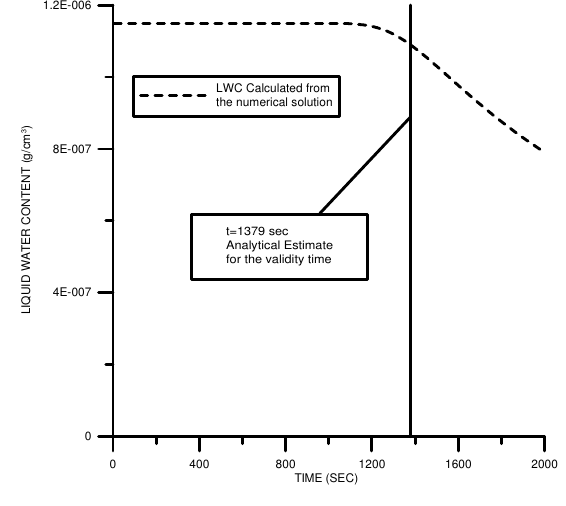
Fig. 3. Size distributions obtained from analytical so- Figure 3. Size distributions obtained from analytical solution of the KCE for the product lution of the KCE for the product kernel K(x,y)=Cxy , ( C =5.49 × 10 10 cm 3 g − 2 s − 1 ), versus size distributions from kernel K(x,y)=Cxy, ( C =5.49×10 10 cm 3 g -2 s -1 ), versus size distributions from numerical numerical solution for two times ( t =1000, 1300s). solution for two times ( t =1000, 1300 sec).